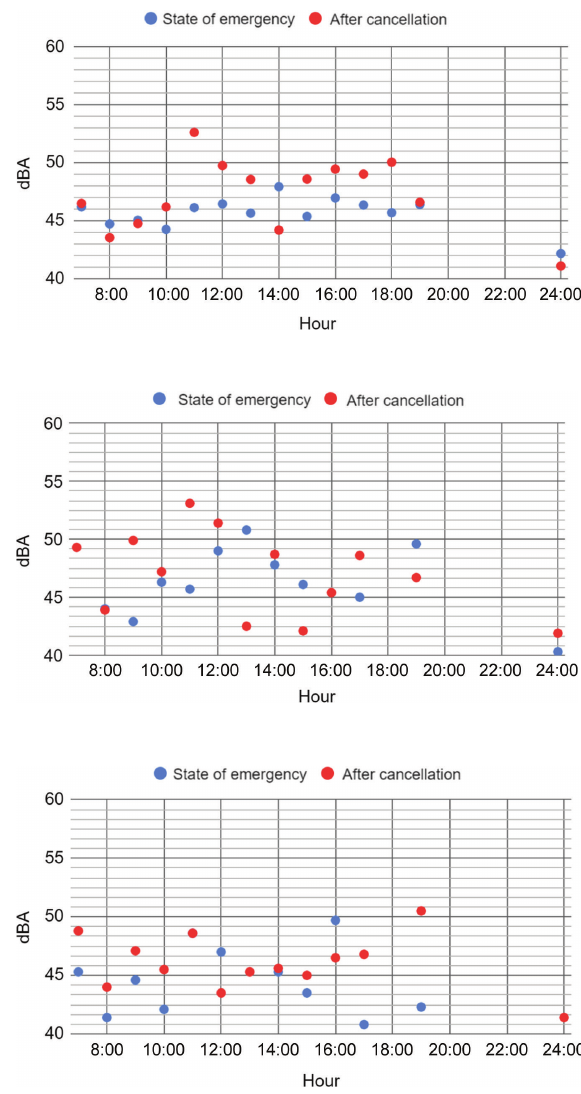
Comparison of the day history of the , T = 30 s) of weekdays noise levels (L Aeq during the state of emergency (blue) and after its cancellation (red). The plot of each hour is the averaged value over all weekdays during the observation period.